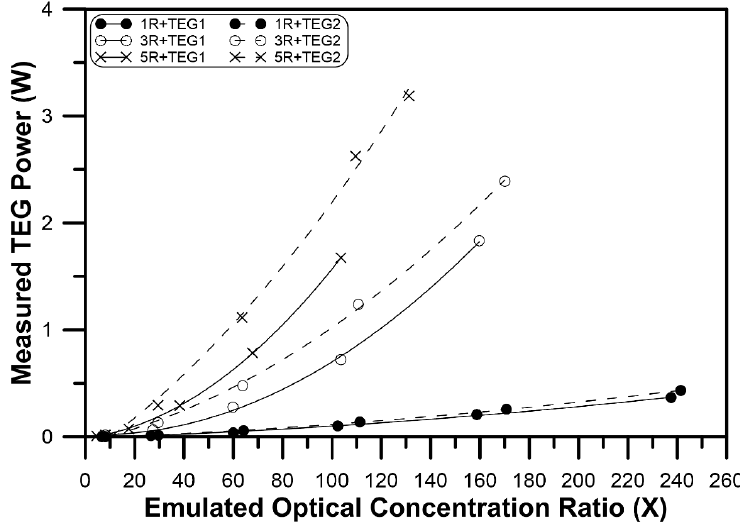
Figure 7. Generated power of the TEGs as a function of the optical concentration ratio.